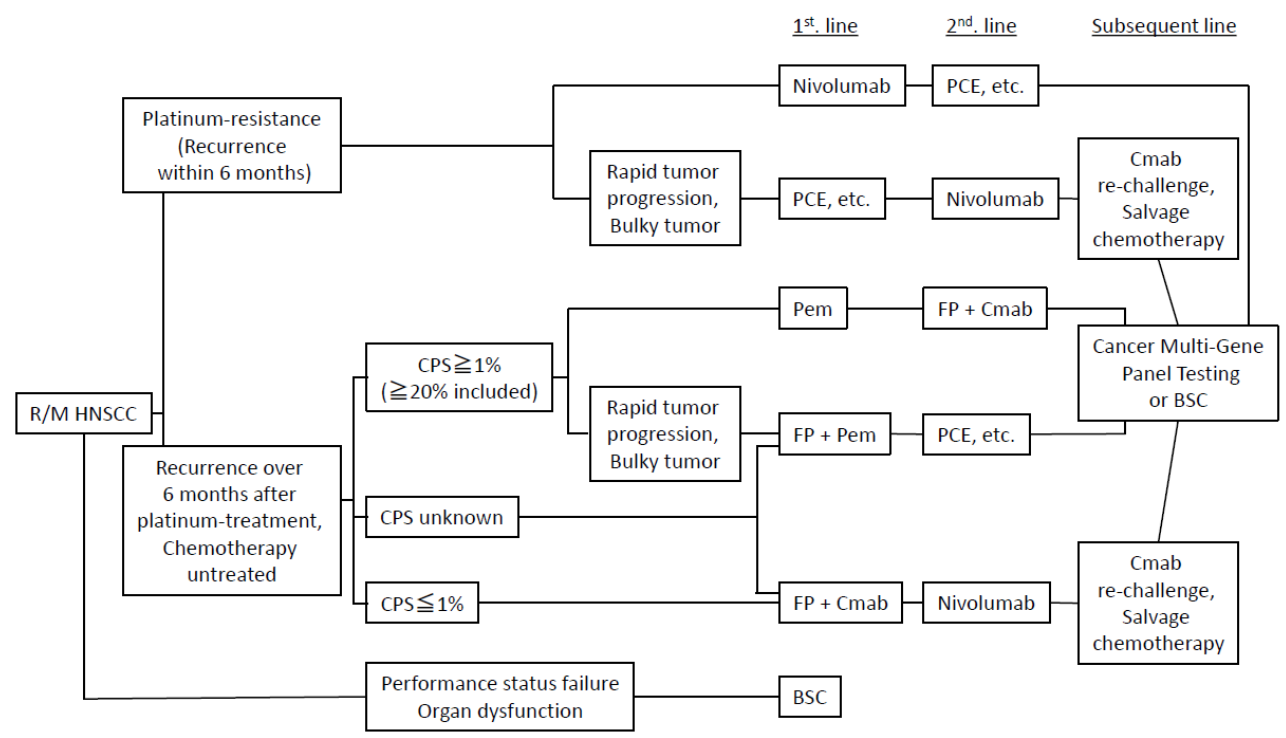
Figure 1. Treatment algorithm of R/M HNSCC. FP: 5-FU + cisplatin, PCE: paclitaxel + carboplatin + cetuximab, Cmab: cetuximab, Pem: pembrolizumab, CPS: combined positive score, BSC: best supportive care. Citations and modifications